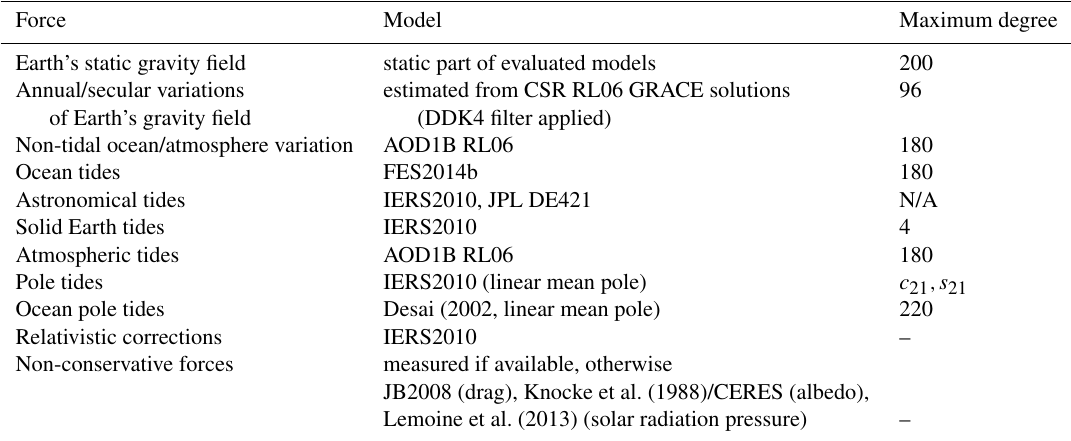
Table 3. Background models used in the dynamic orbit